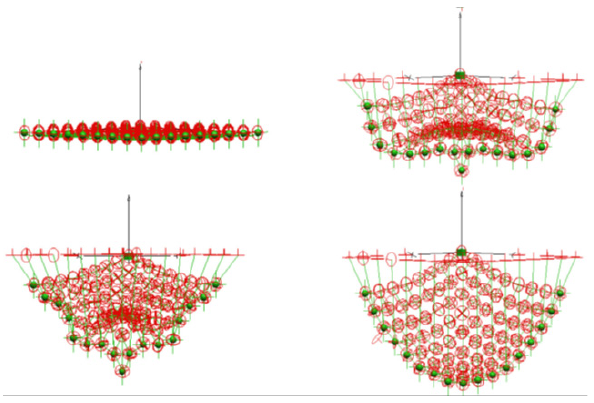
Figure 22: Application of MRA with different number of itera- tions